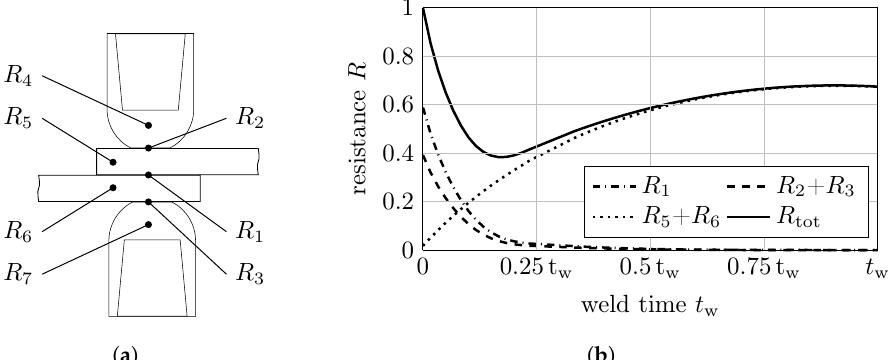
Figure 2. ( a ) Contact resistances R 1 3 and individual material resistances R 4 − during typical spot-welding process with resulting total resistance R tot (schematic,